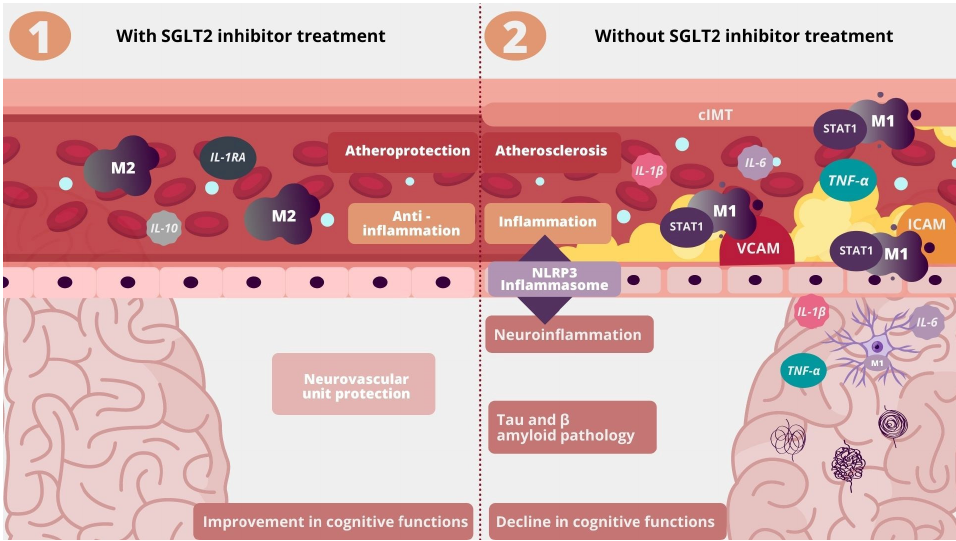
Figure 2. Influence of SGLT2 inhibitors on inflammation, atherosclerosis, and neuroinflammation. IL-1RA—Interleukin 1 Receptor Agonist, cIMT—carotid intima-media thickness, STAT1—Signal transducer and activator of transcription 1, VCAM—Vascular Cell Adhesion Molecule; ICAM- Intracellular Adhesion Molecule.